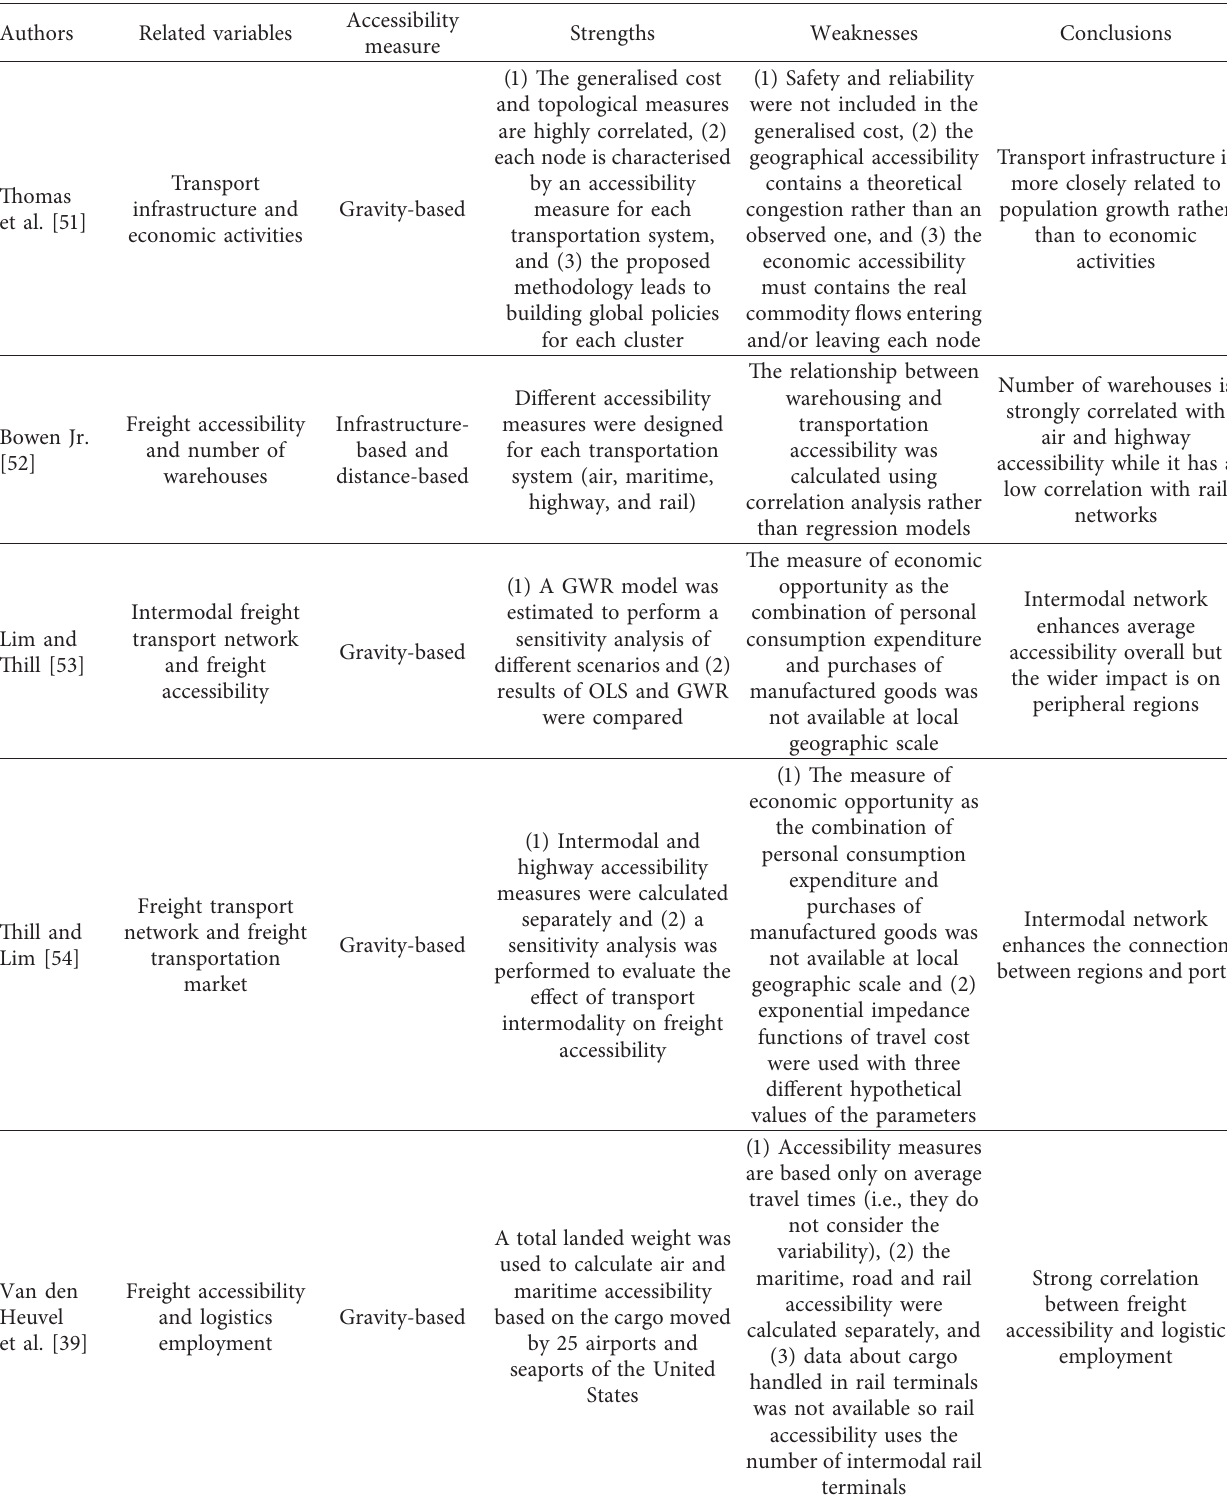
Table 1: Review of related